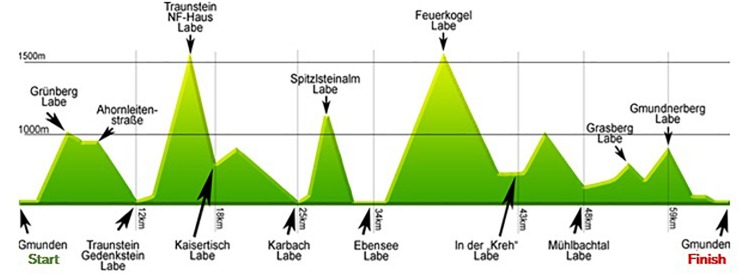
Race profile and refreshment stations throughout the course. Labe, refreshment station during the course.